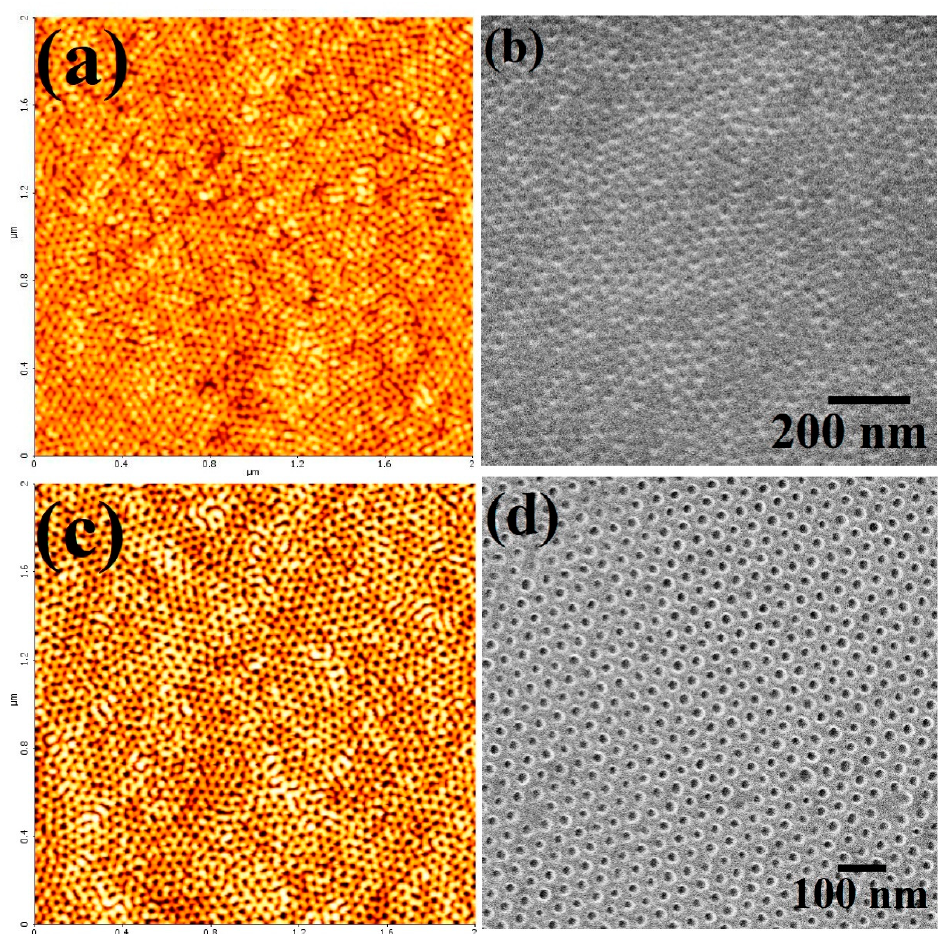
Figure 5. AFM ( a , c ) and SEM ( b , d ) images of PS-b-PEO thin film after solvent annealed in toluene/water at 50 °C and after ethanol treatment respectively.